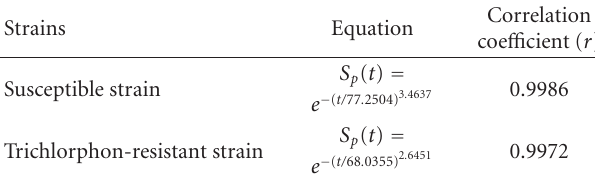
Table 5: The adults survival lines of two strains of B. dorsalis.